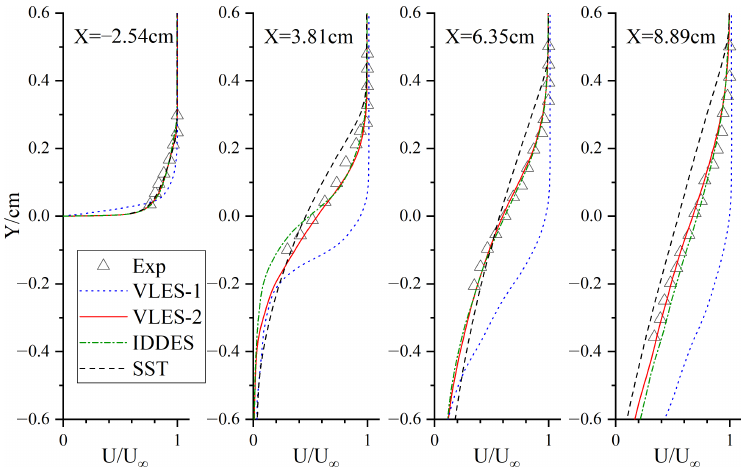
Figure 4. Comparisons of mean streamwise velocity profiles at each